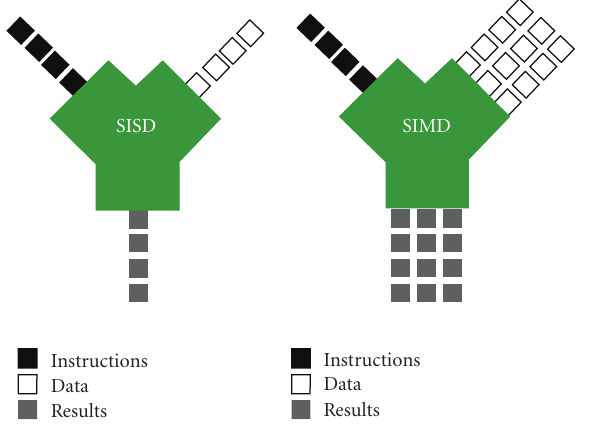
Figure 2: Comparison between SISD and SIMD [2].